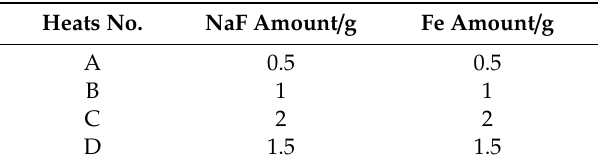
Table 1. Composition of